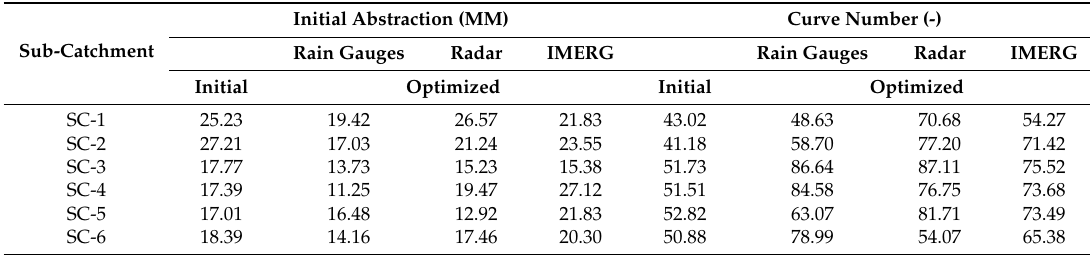
Table 8. Calibrated model parameters for the Soil Conservation Service (SCS) Curve Number Loss Method.